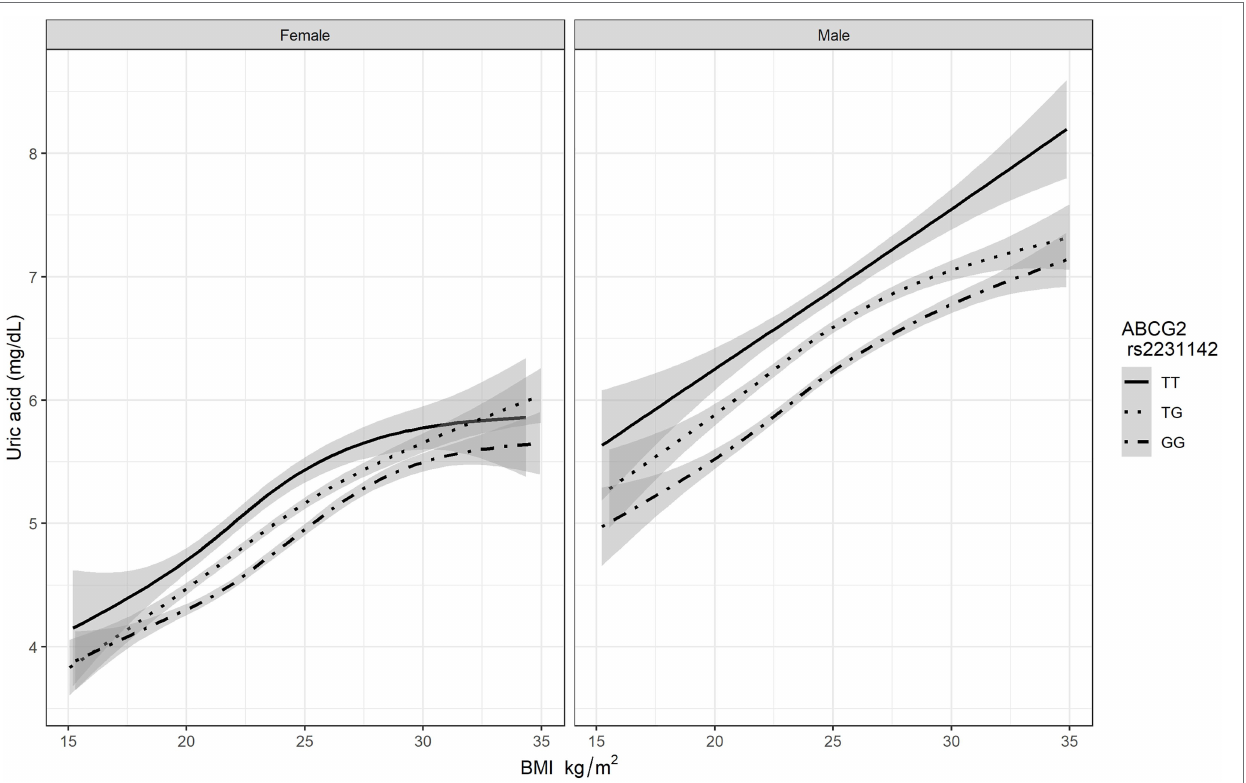
FIGURE 1 | The association BMI and serum uric acid level based on different genotypes of ABCG2